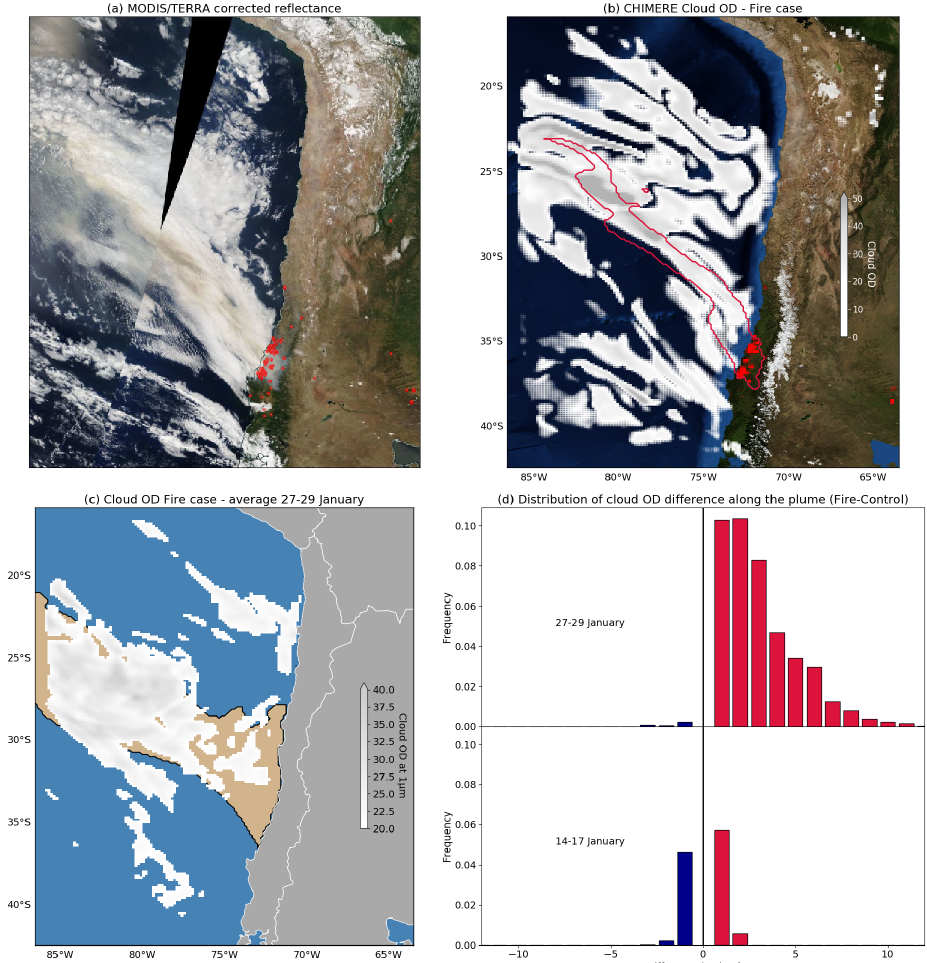
Figure 7. ( a ) Corrected reflectance product from MODIS/TERRA on 27 January provided by the NASA EOSDIS Worldview platform. Red spots show the fire and thermal anomalies as retrieved by MODIS. ( b ) CHIMERE simulated cloud OD at 1µm at the passage time of MODIS on 27 January. Red spots correspond to the main emission sites at that time in the simulation. Red contour shows the shape of the aerosol plume originating from the fires. Map background layer: Imagery World 2D, ©2009 ESRI. ( c ) Cloud OD at 1µm in the fire case averaged for 27 to 29 January (colormap). The light brown shade shows the extent of the PM plume originating from the fires. ( d ) Distribution of the cloud OD change in the fire case compared to the control case, over the region defined by the light brown shade in ( c ), for a fire period (27–29 January) and a non-fire period (14–17 January). NB: the central [ − 0.5, 0.5] bin is removed for improved